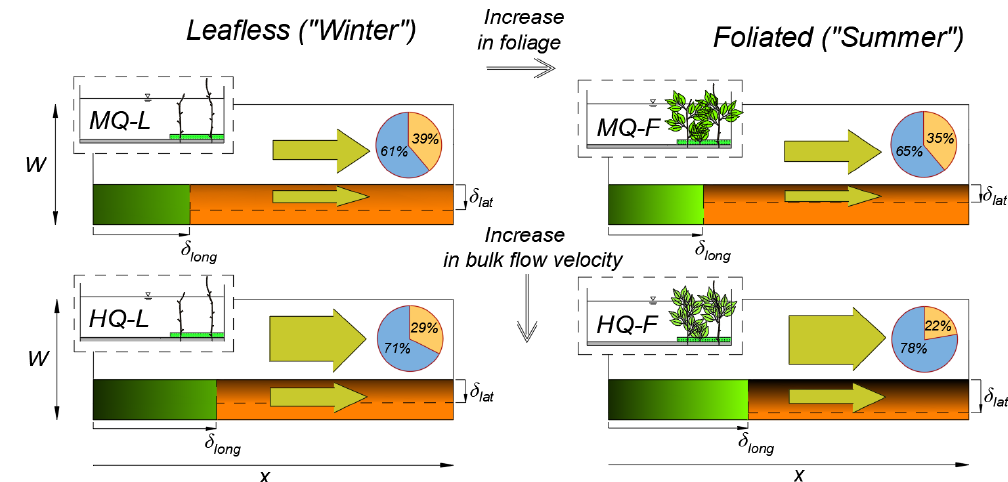
Figure 14. Summary and conceptualization of the net deposition patterns observed, in plan view with cross-sectional inserts for the four runs with differences in mean bulk flow velocity and foliation (see Table 1). The decreasing intensity of the green shade denotes a reduction in net deposition between the leading edge of the vegetation and the longitudinal position δ long where deposition is 0.2 m max . Downstream of δ long , the lateral reduction in the net deposition observed is conceptualized by the decreasing intensity of the brown shade, with δ lat indicating the lateral position where deposition is 0.4 m max . I.e., the thickness of the yellow arrows indicates the magnitude of the cross-sectionally averaged SS load at the investigated cross-section (at x / h = 68) in the unvegetated ( q ss,UP ) and vegetated ( q ss,VP ) parts of the channel. The pie chart indicates the relative share of the SS load in the unvegetated (blue) and vegetated (orange) channel parts, respectively. MQ = medium flow rate (50 L / s); HQ = high flow rate (83 L / s); L = leafless; F = foliated.